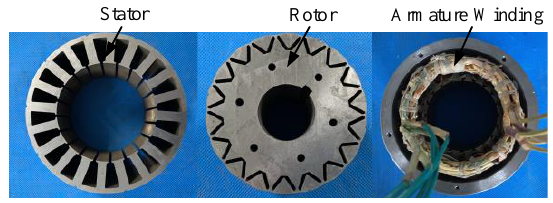
Figure 1. Prototype of five-phase FTPMSM. Table 1. Parameters of the FPFTPM motor.